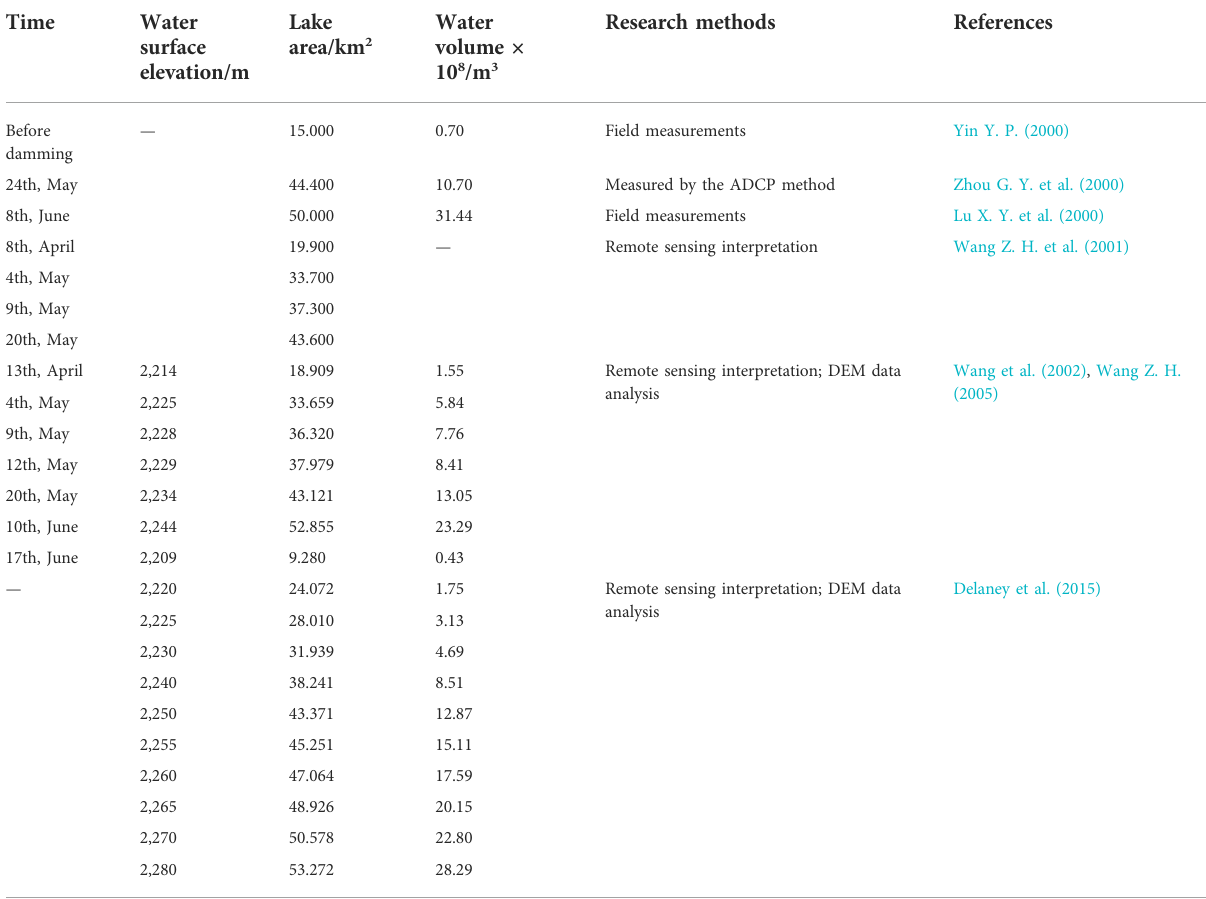
TABLE 5 The statistical table of lake volume of the Yigong landslide dam in